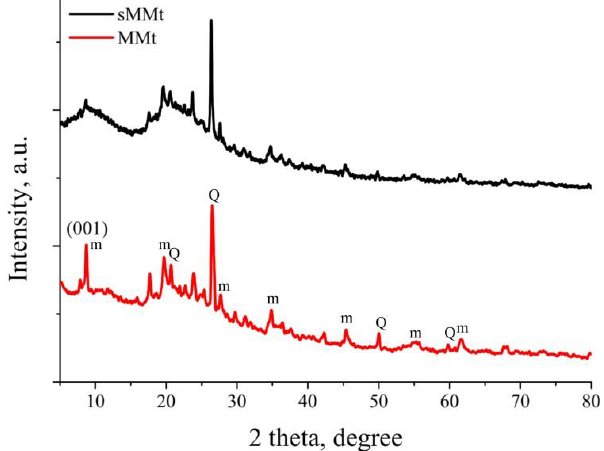
Fig. 2 XRD patterns of MMt and